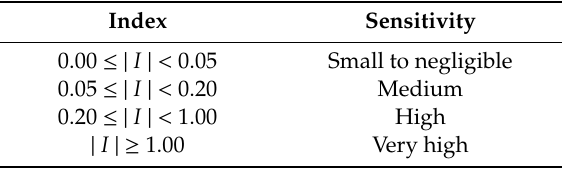
Table 3. Categorization of sensitivity index used in this